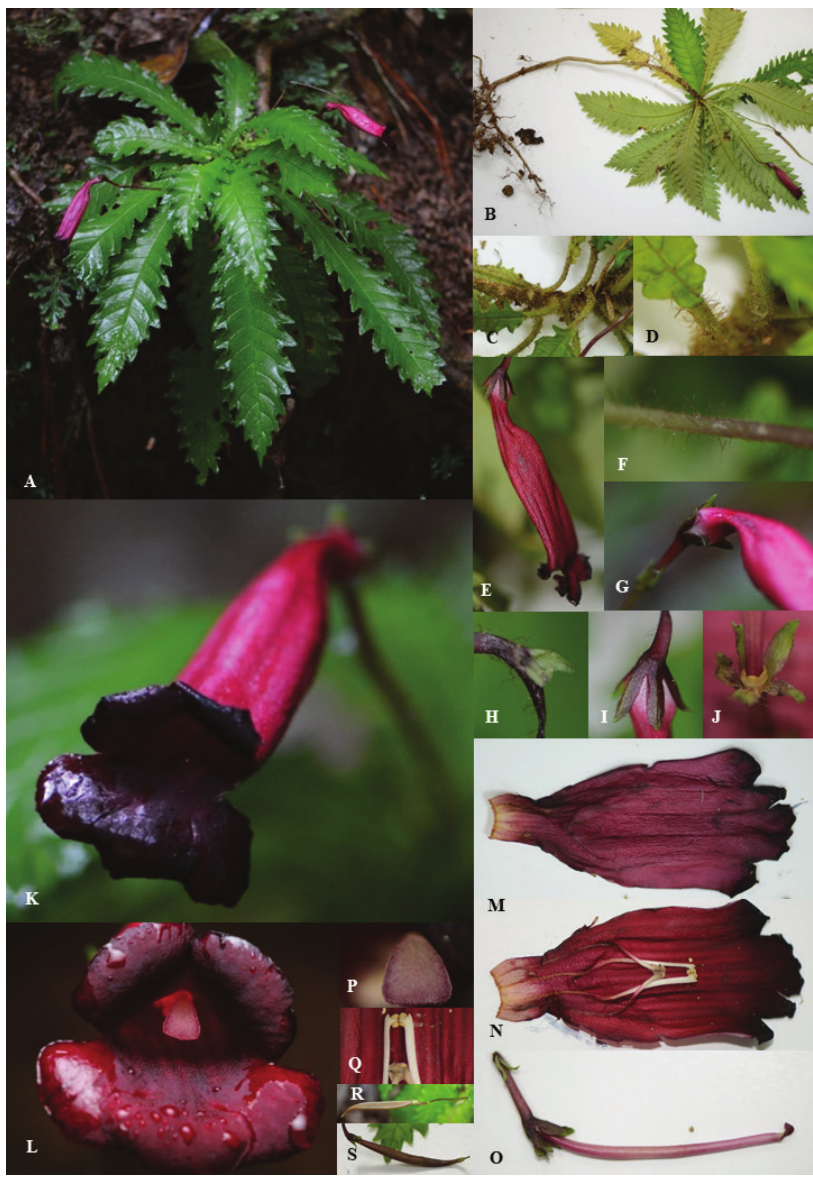
Figure 2. Ridleyandra merohmerea Siti Munirah & Zaharil. A, B habit C leaf arrangement D petiole with hairs E flower from side view F peduncle with hairs G corolla curve H bracts I sepals J nectary K flower with five lobes L flower lobes dark red M corolla outer surface N corolla surface inside with stamens O pistil P stigma Q anthers R fruit capsule open S young fruit (Photo: A – K, M–S Siti-Munirah MY, L Zaharil